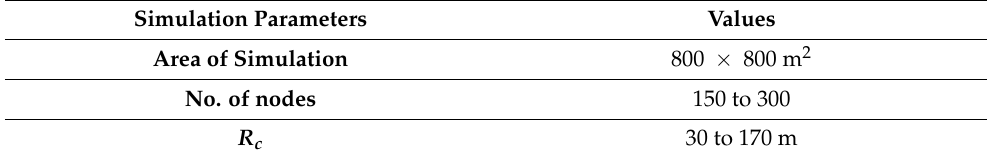
Table 3. Parameters for simulation. Simulation